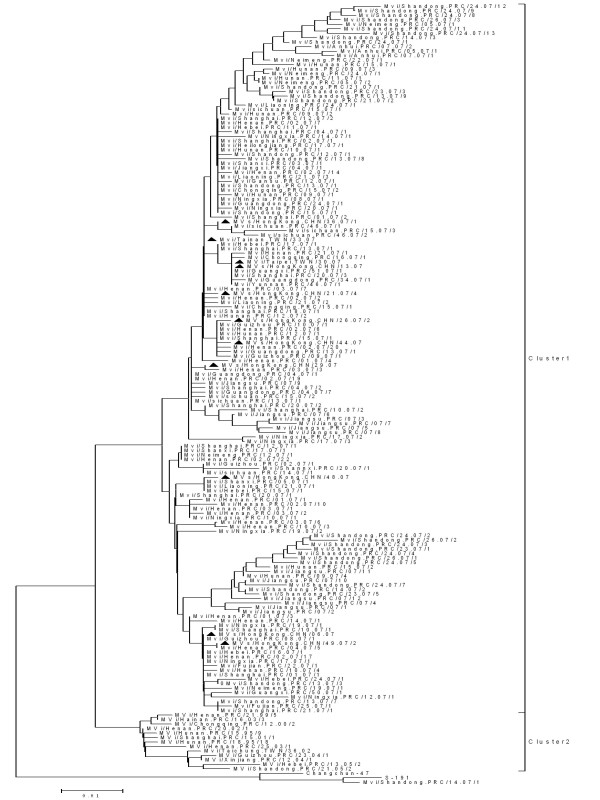
Phylogenetic tree of measles wild-type virus strains of China in 2007 and H1 reference MeV strains based on the 450 nucleotide sequences coding for the COOH-terminus of the nucleoprotein. The MeV isolates from Taiwan and Hong Kong China were identified by a BLAST search from of GenBank (shown by black triangles).